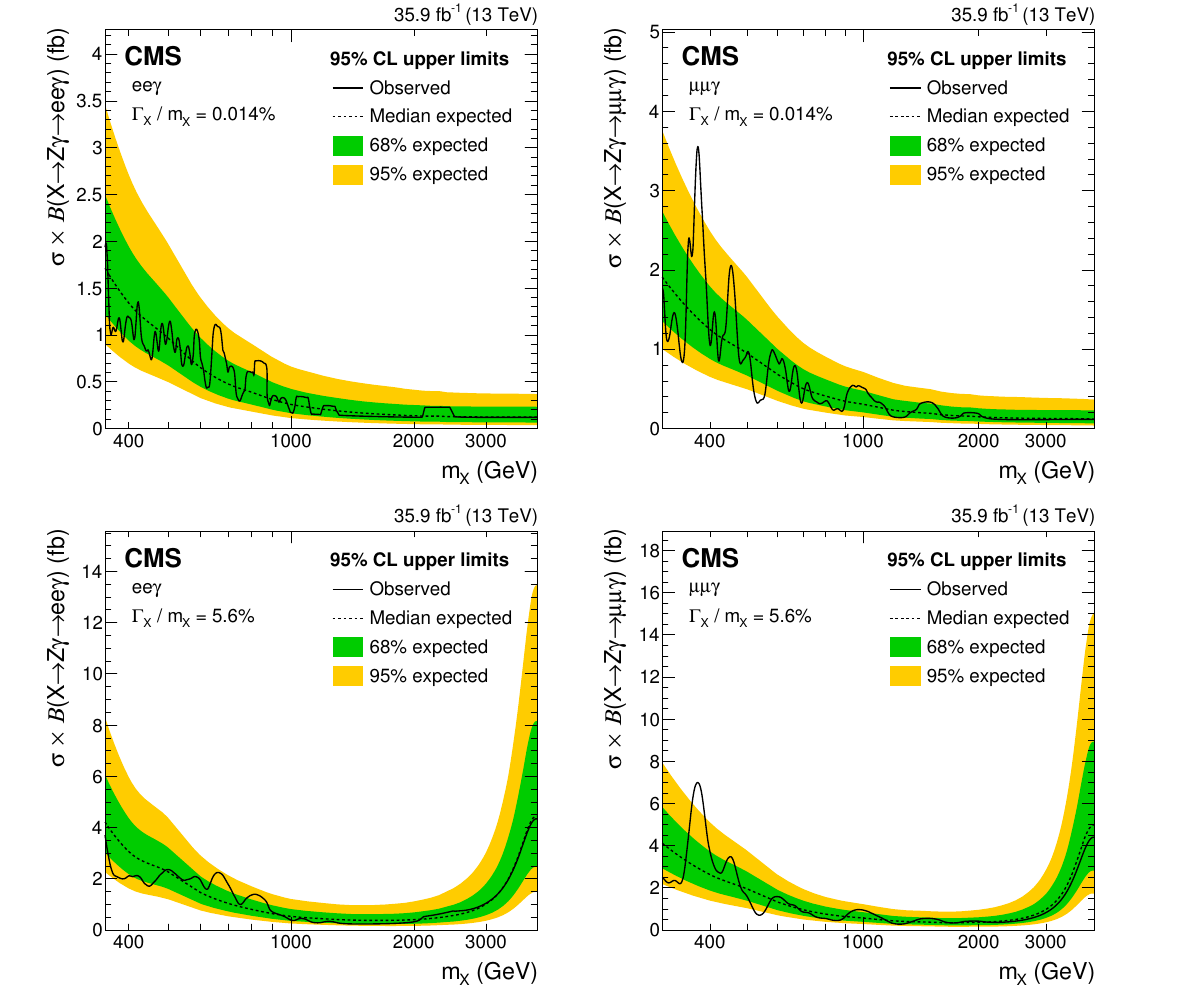
Figure 3 . Observed (solid) and expected (dashed) 95% CL upper limits on (cid:27) (X ! Z (cid:13) ) B (Z ! ‘‘(cid:13) ), as a function of signal mass m X for the ee (cid:13) (left column) and (cid:22)(cid:22)(cid:13) (right column) channels, and for narrow (upper row) and broad (lower row) spin-0 resonances. The green and yellow shaded bands correspond to respective 68 and 95% CL ranges in the expected limits for the background-only